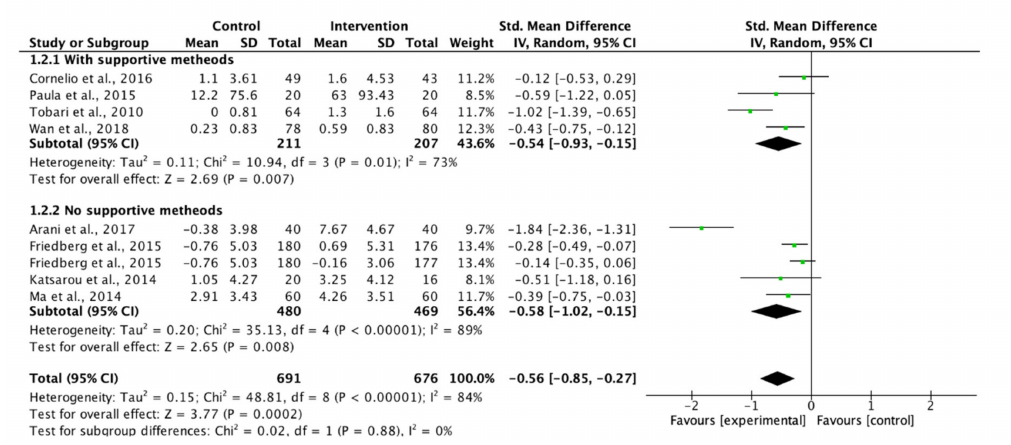
Figure 6. Forest plot of supportive methods on adherence to dietary recommendations.